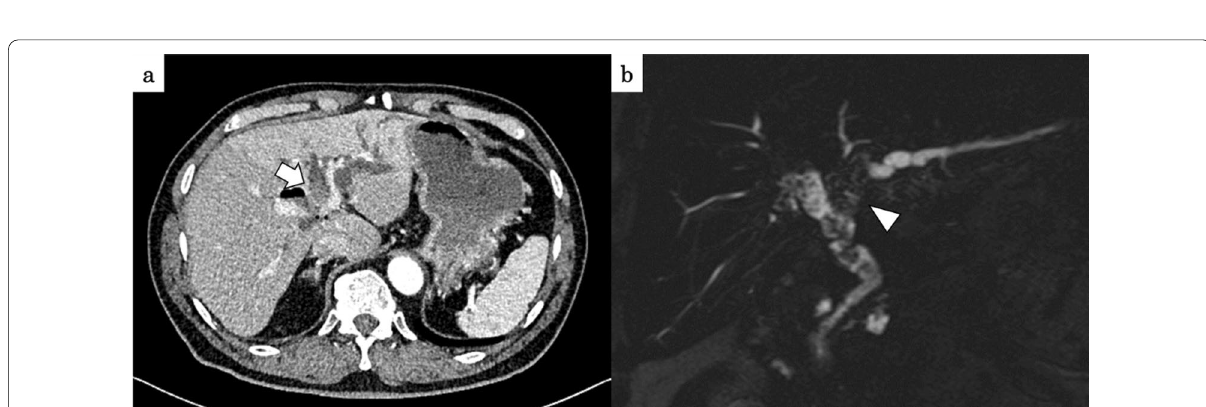
Fig. 4 Preoperative imaging examinations of case 2. a Enhanced CT imaging showed tumor with a slight enhancement in the intrahepatic left bile ducts (white arrow). b Magnetic resonance cholangio-pancreatgraphy (MRCP) revealed a defect lesion from the common bile duct to the left bile duct